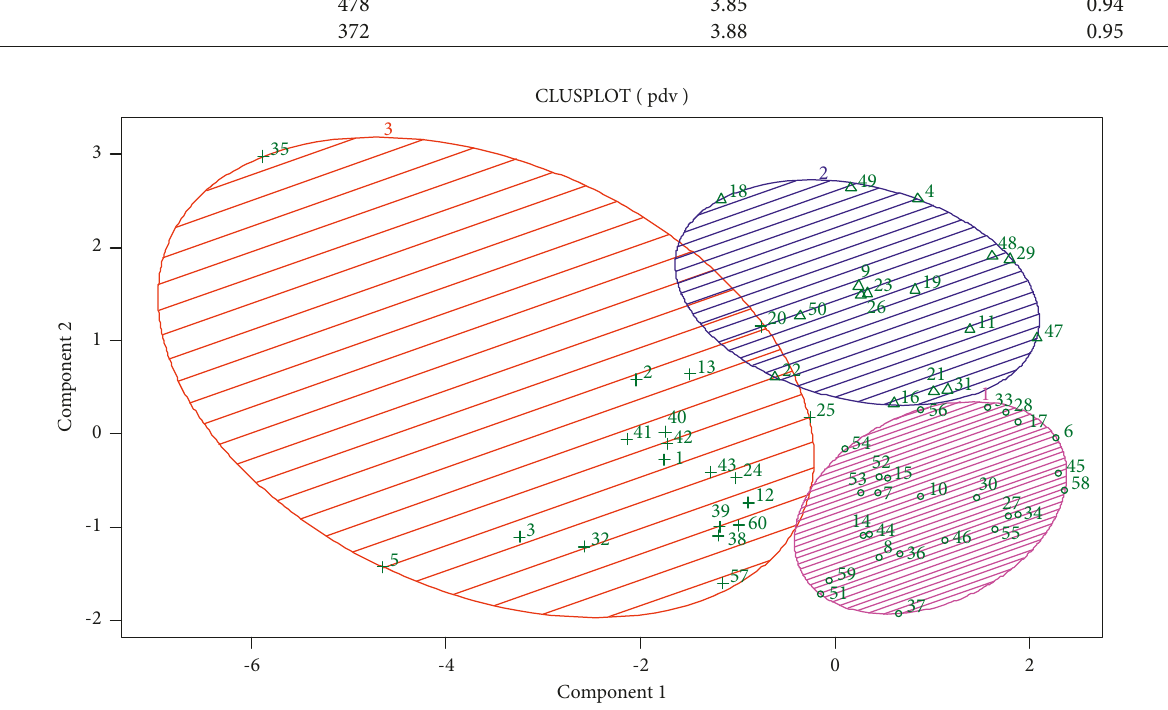
Figure 4: Clusplots of bivariate graphical representation of clustering ( K � 3)